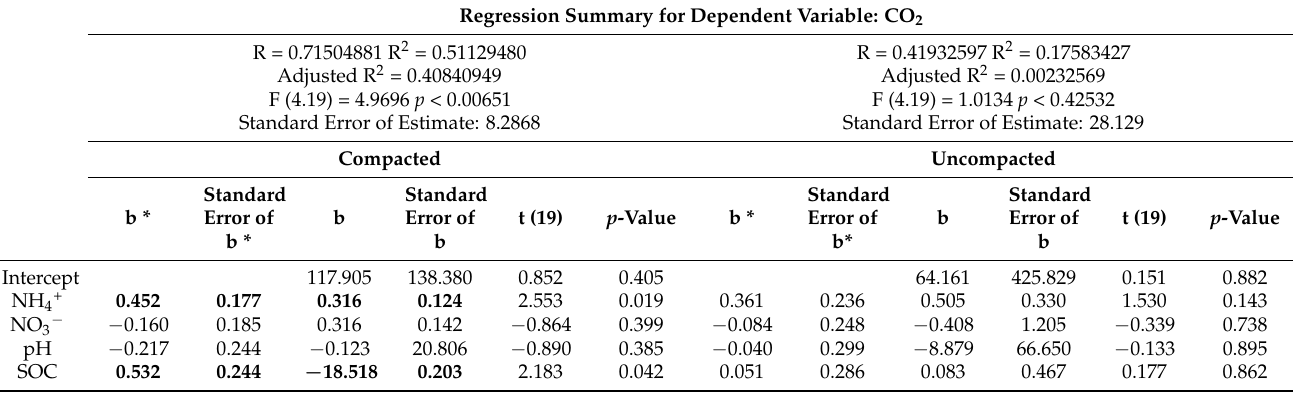
Table 3. Multiple regression models between key soil parameters and CO 2 emissions in compacted and uncompacted Luvisol ( n = 24). Regression Summary for Dependent Variable: CO